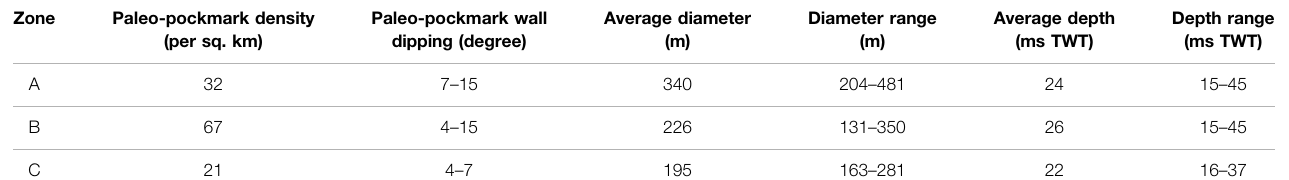
TABLE 1 | Summary of the paleo-pockmark characteristics of each zone.